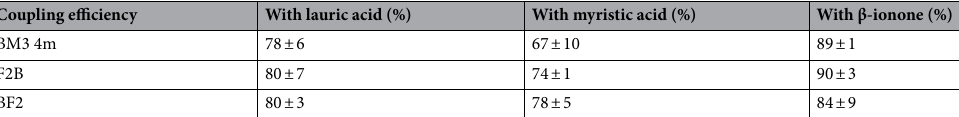
Table 2. Coupling efficiency of individual BM3 4m and the fusions F2B and BF2. The errors are the standard deviation.